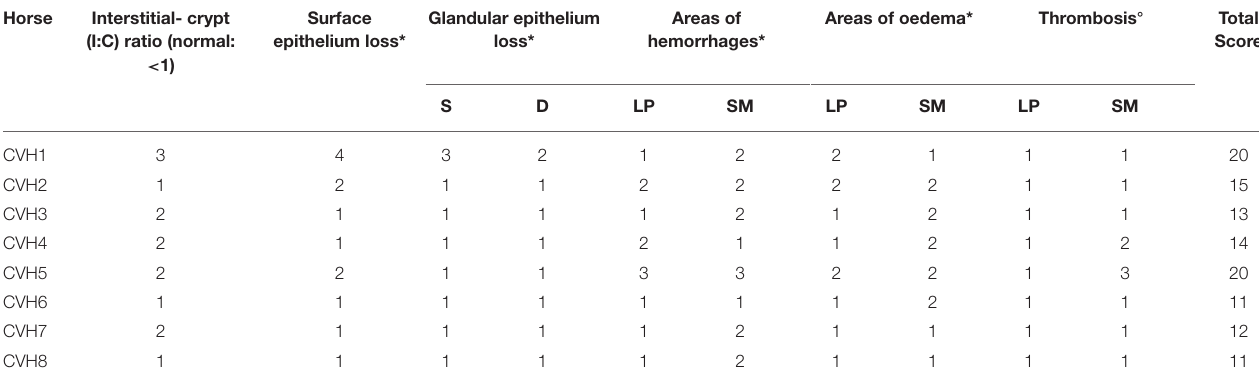
TABLE 3 | Results of the histomorphologic scoring system evaluation of the tissue sections included in the study. Horse Interstitial- crypt (I:C) ratio (normal: <